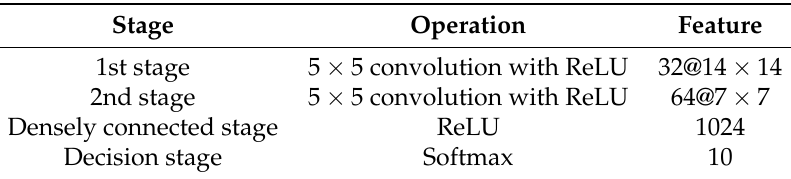
Figure 7. Examples of handwritten digit number images of the MNIST handwritten digits [44] database. Table 1. The stage, operation, and feature of the classifier for hand gesture recognition. (ReLU means that the layer uses rectified linear unit as activation